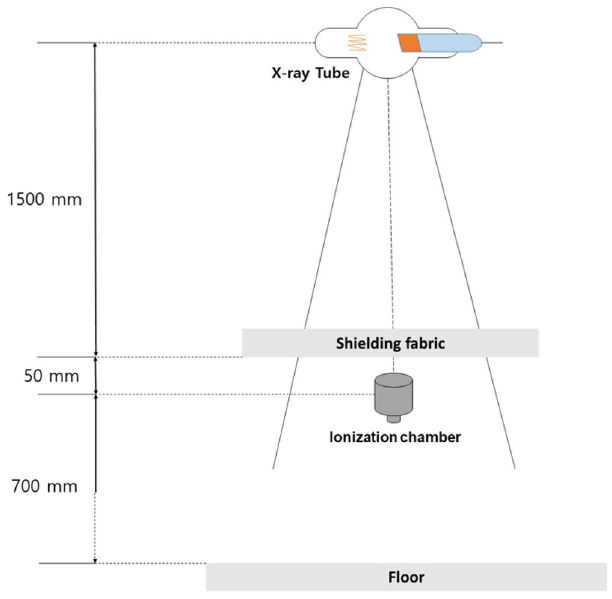
Figure 7. Shielding performance test schematic.